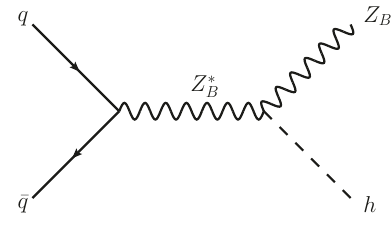
Figure 8 . Associated Z B (cid:0) h production